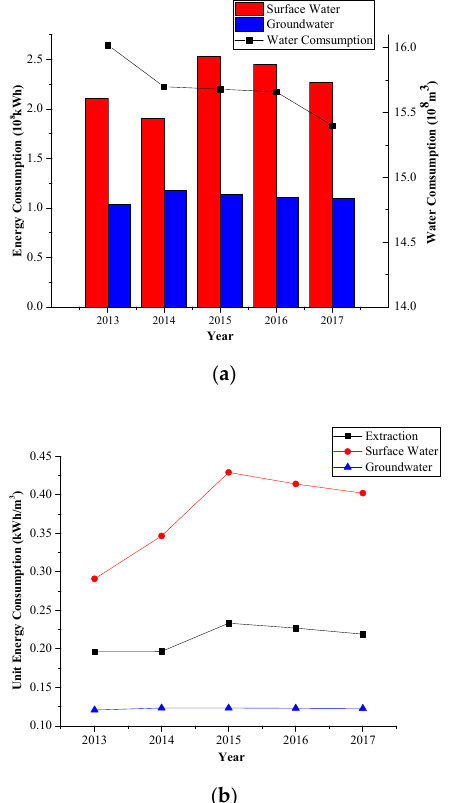
Figure 6. Year-by-year change of energy consumption of the water extraction stage in Ordos, China. ( a ) Energy consumption of water extraction; ( b ) energy consumption of the per unit